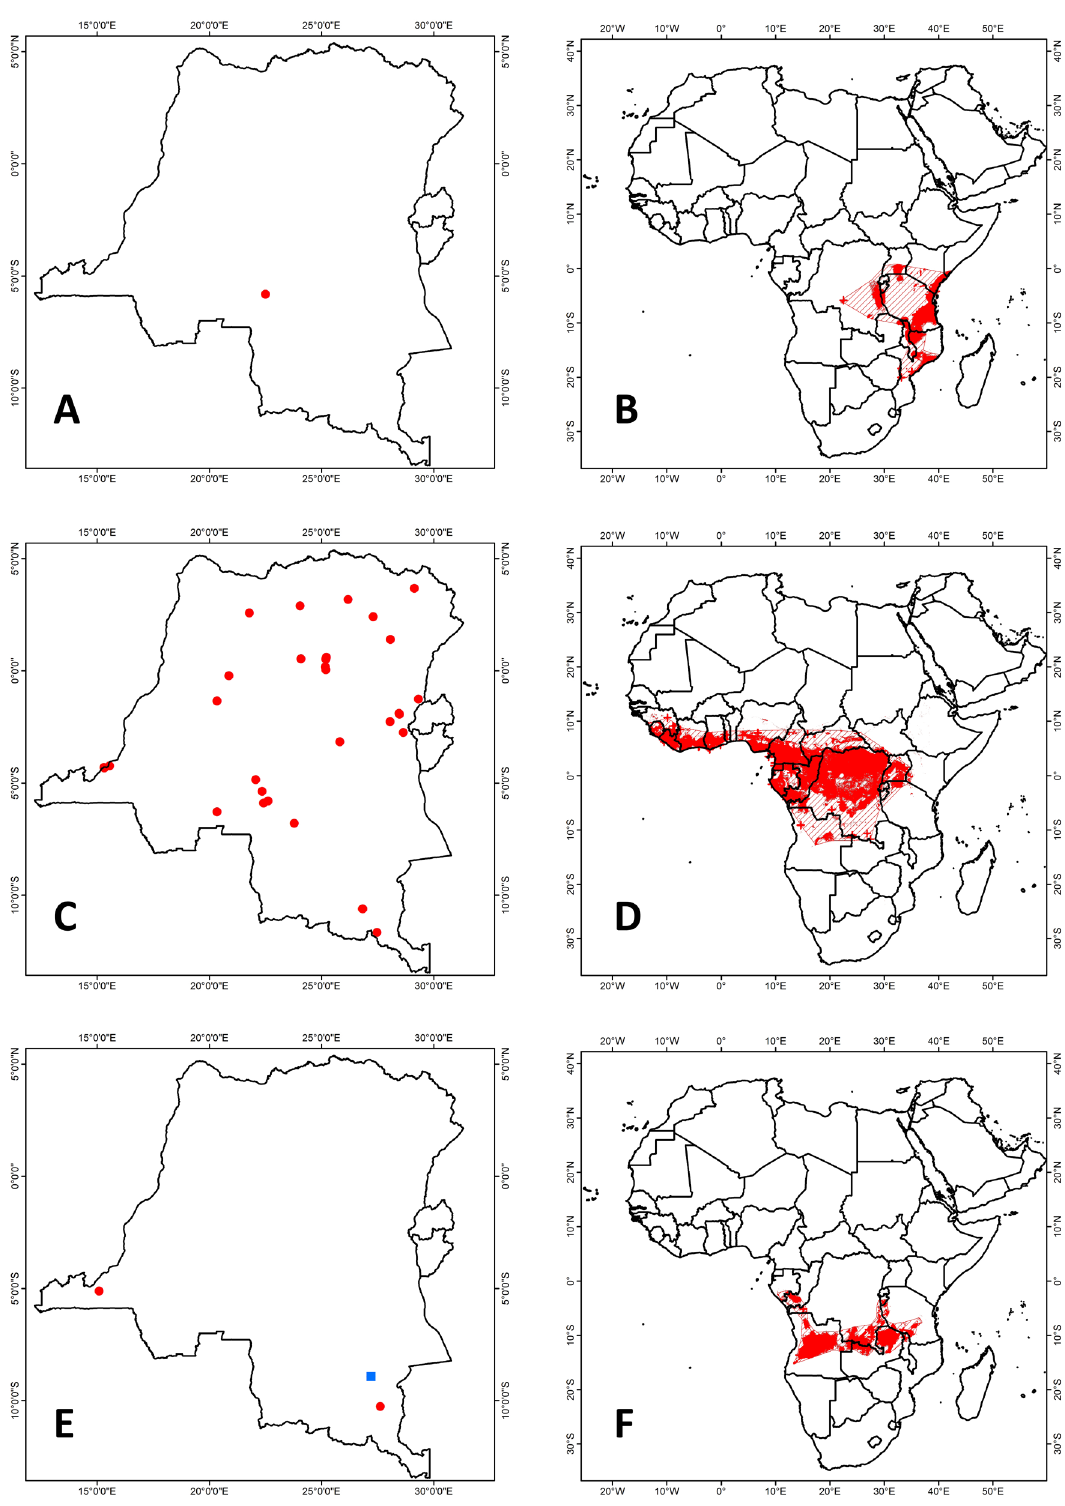
Fig. 8. Distribution maps. A–B . Myonycteris relicta Bergmans, 1980. C–D . Myonycteris torquata (Dobson, 1878). E–F . Plerotes anchietae (Seabra, 1900). A, C, E. Distribution in the CRB area. B,